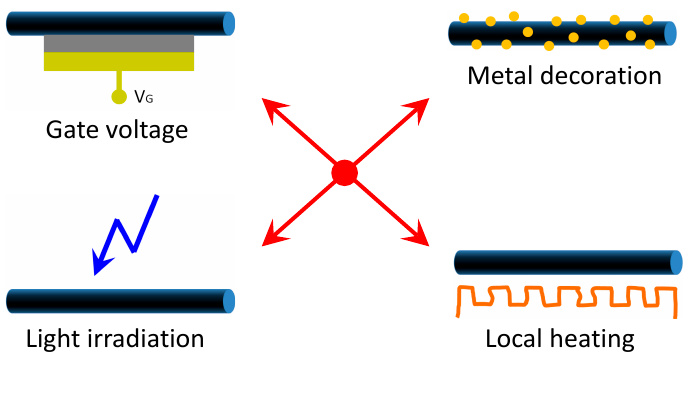
Figure 14. In addition to gate voltage, other methods including metal particle decoration, light irradiation and local heating can be used as effective additional means to modulate the nanowire channel in the FET gas sensors for improved sensing performance, such as sensitivity, selectivity and response